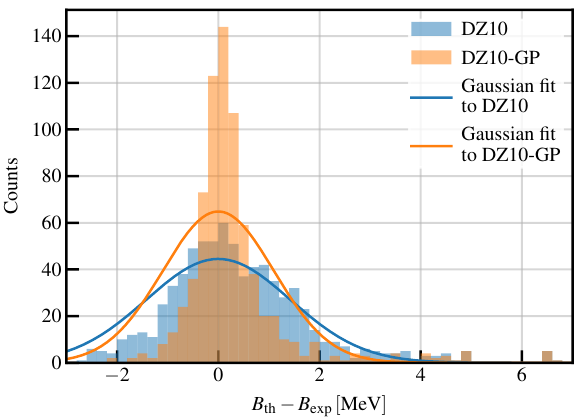
Figure 7. Same as Figure 5 but for extrapolated masses. See text for details.